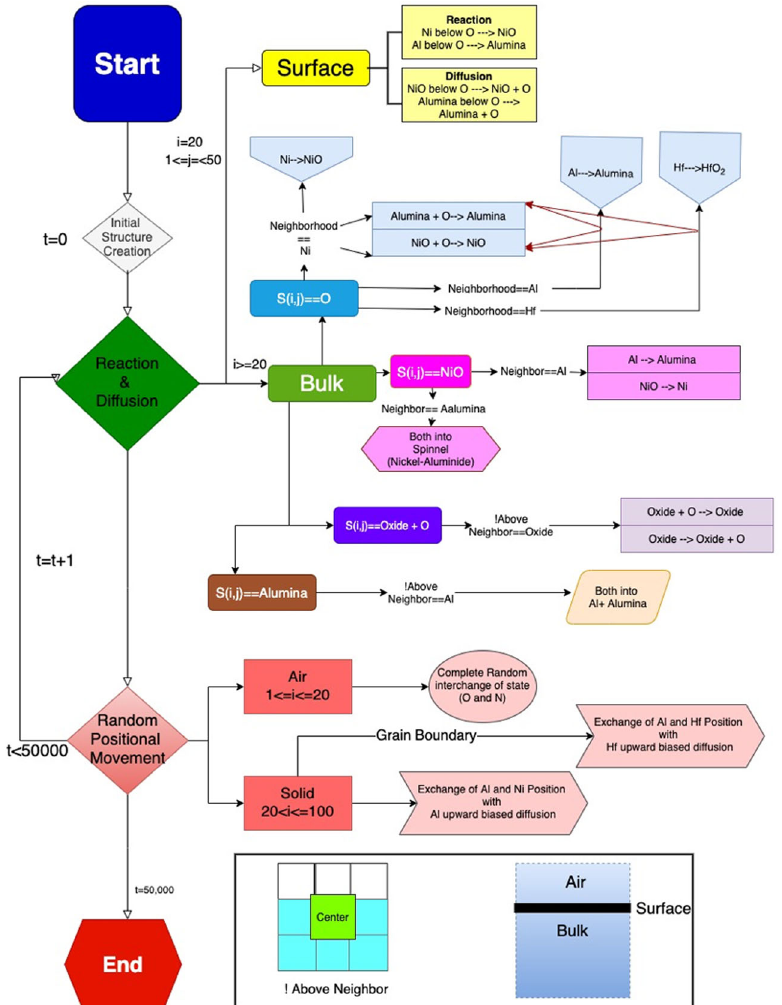
Fig. 2 A fl owchart representing the simulation procedure for NiAl oxidation. The details of the fl owchart are described in the Methods